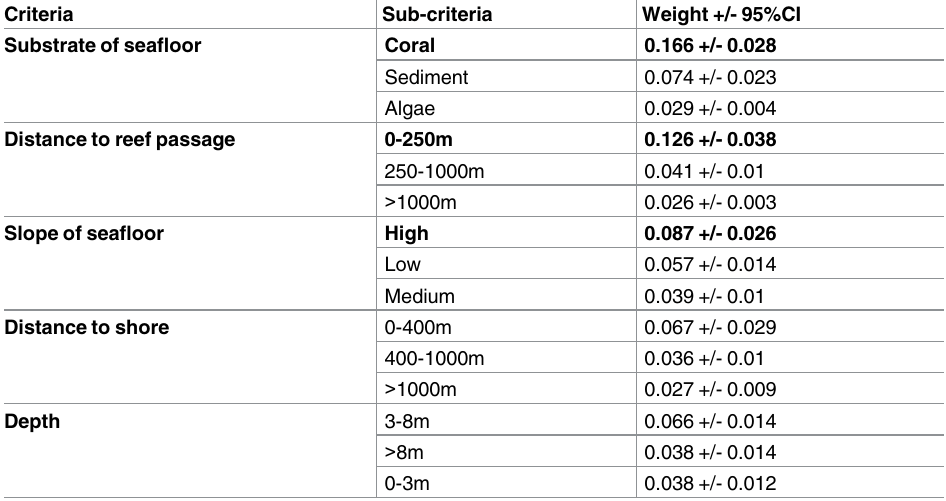
Table 1. Averaged sub-criteria weights (+/- 95%CI) obtained from AHP exercisesperformed with local fishers to estimatetheir preferencefor fishing grounds. The three sub-criteria rankedhigherare indi- cated in